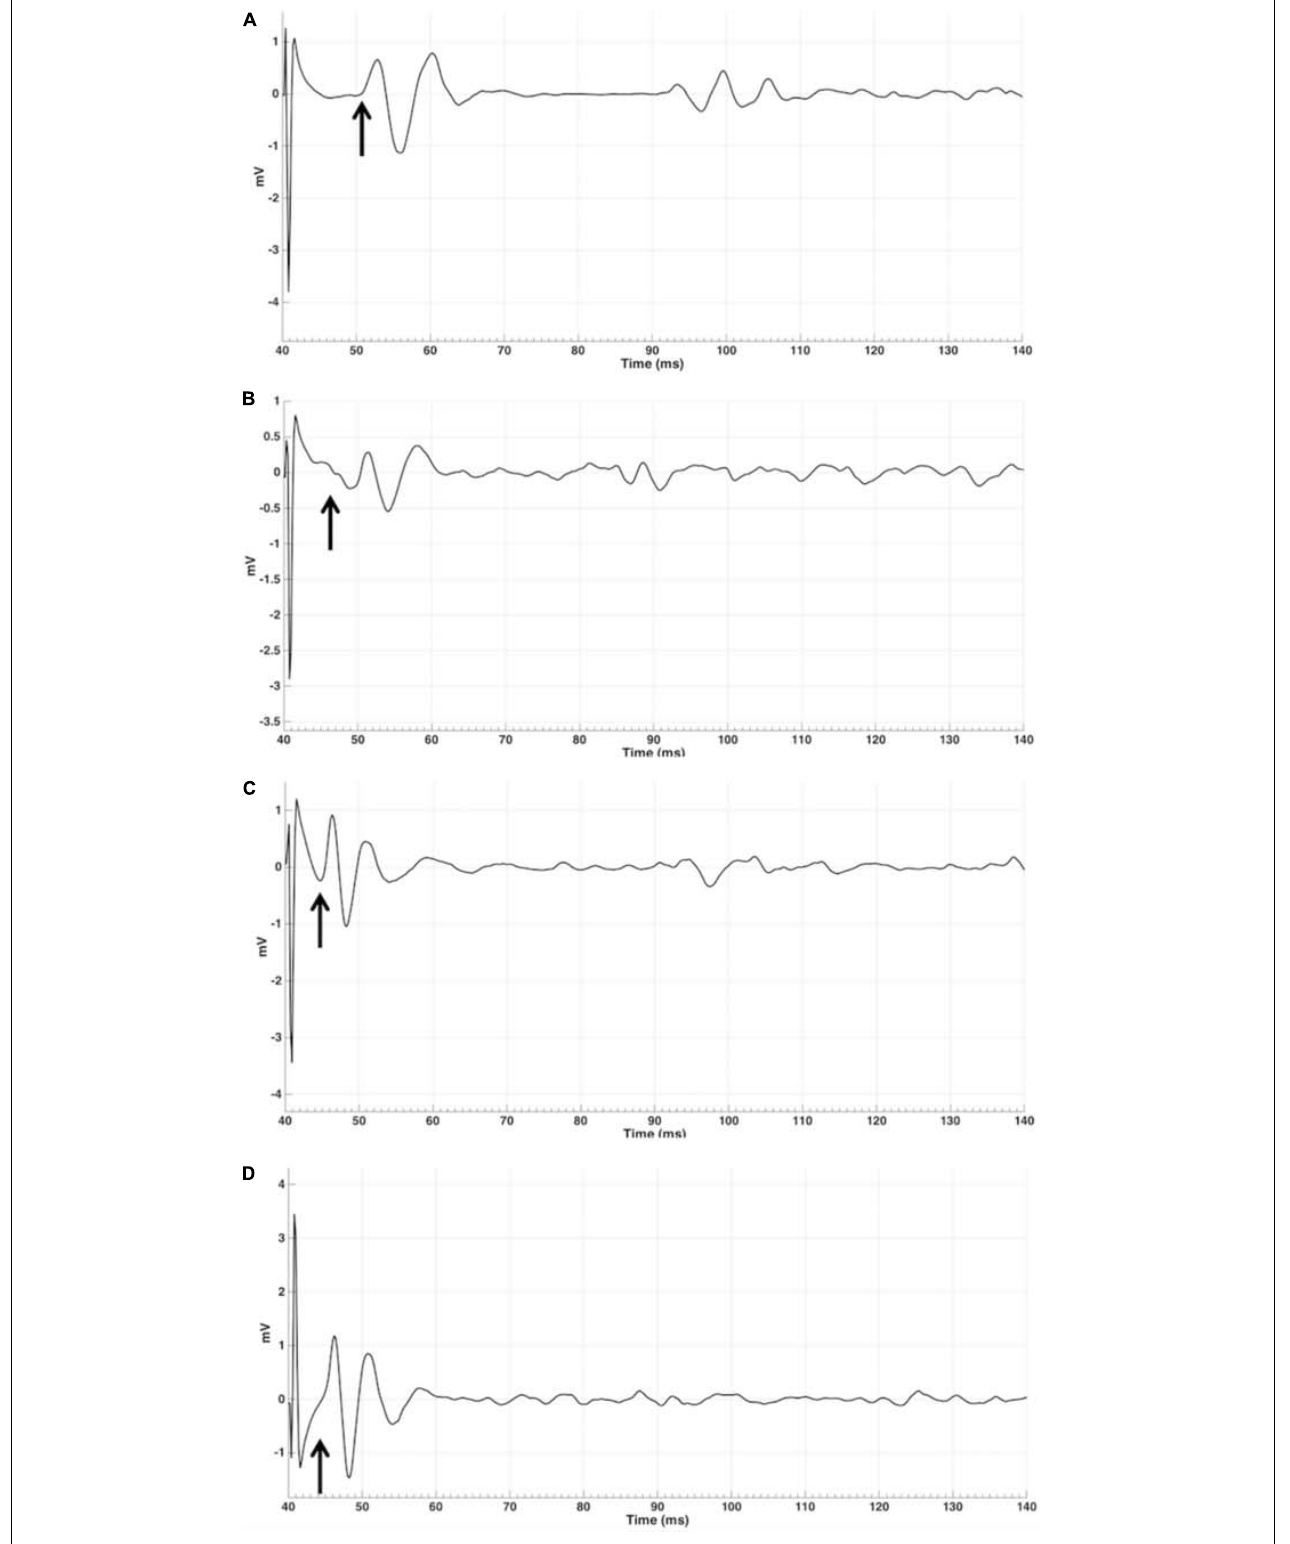
FIGURE 3 | MEP EMG traces for a single MEP for subject 9 for four orientations: contralateral 45 (A) , contralateral 135 (B) , ipsilateral 0 (C) , and 180 (D) in mV. Arrows indicates approximate start of MEP, measured from TMS pulse at 40 ms into the trial.